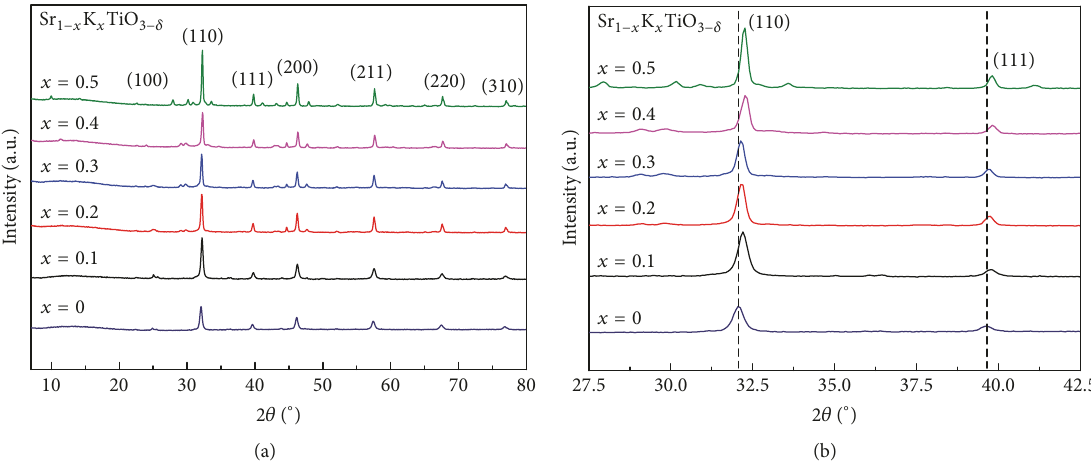
Figure 1: XRD patterns of the as-synthesized Sr 1−𝑥 K 𝑥 TiO 3−𝛿 .